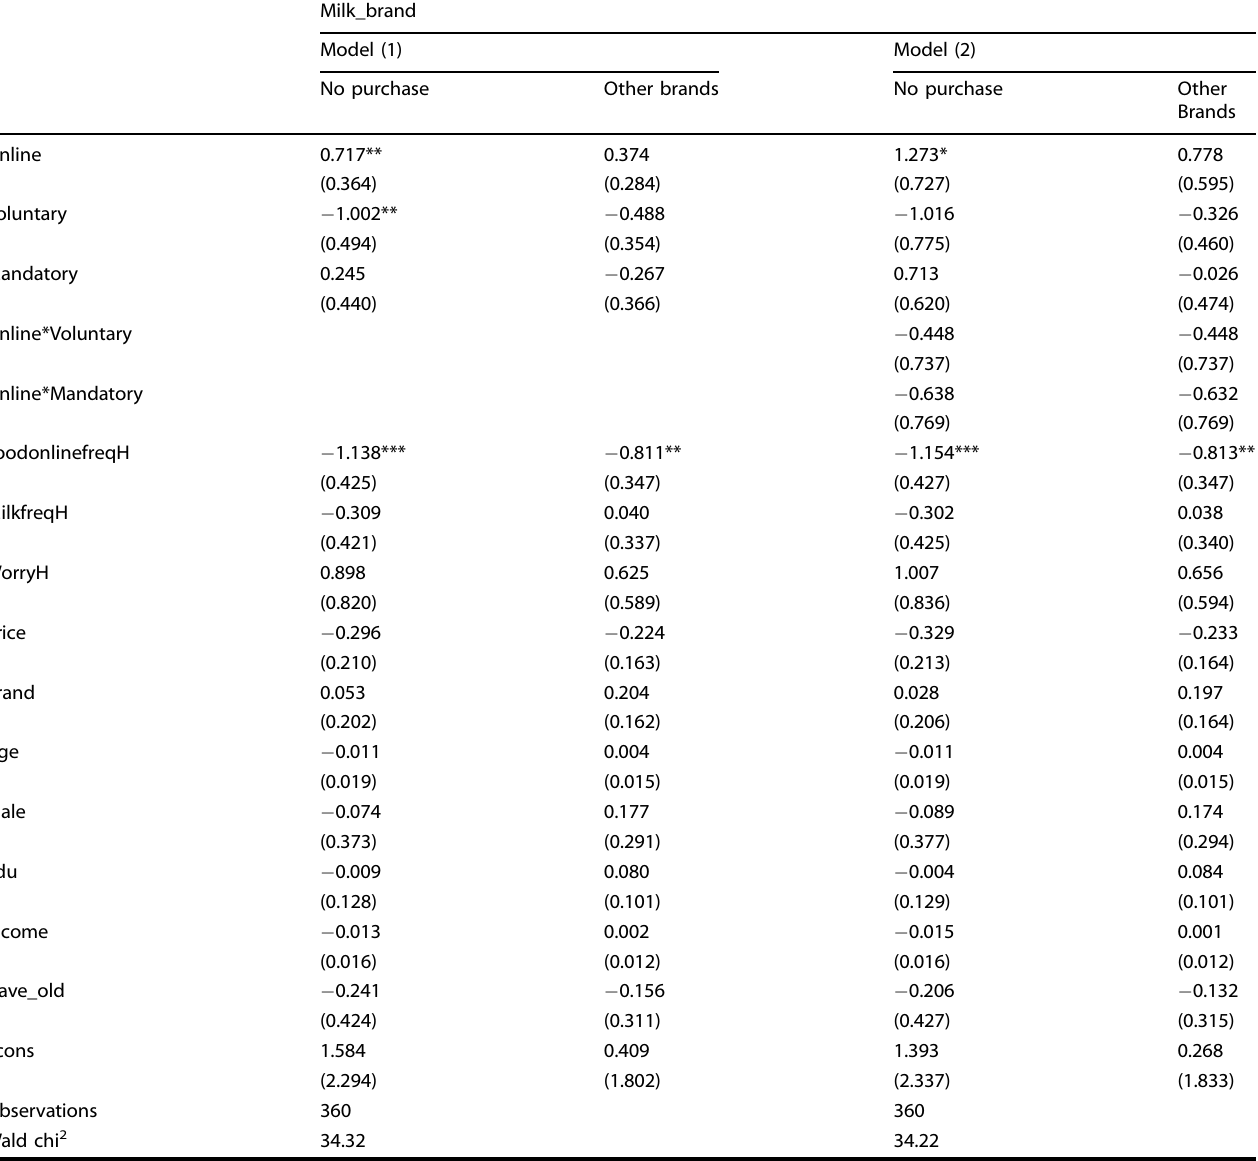
Table 2. Multinomial probit model results of milk